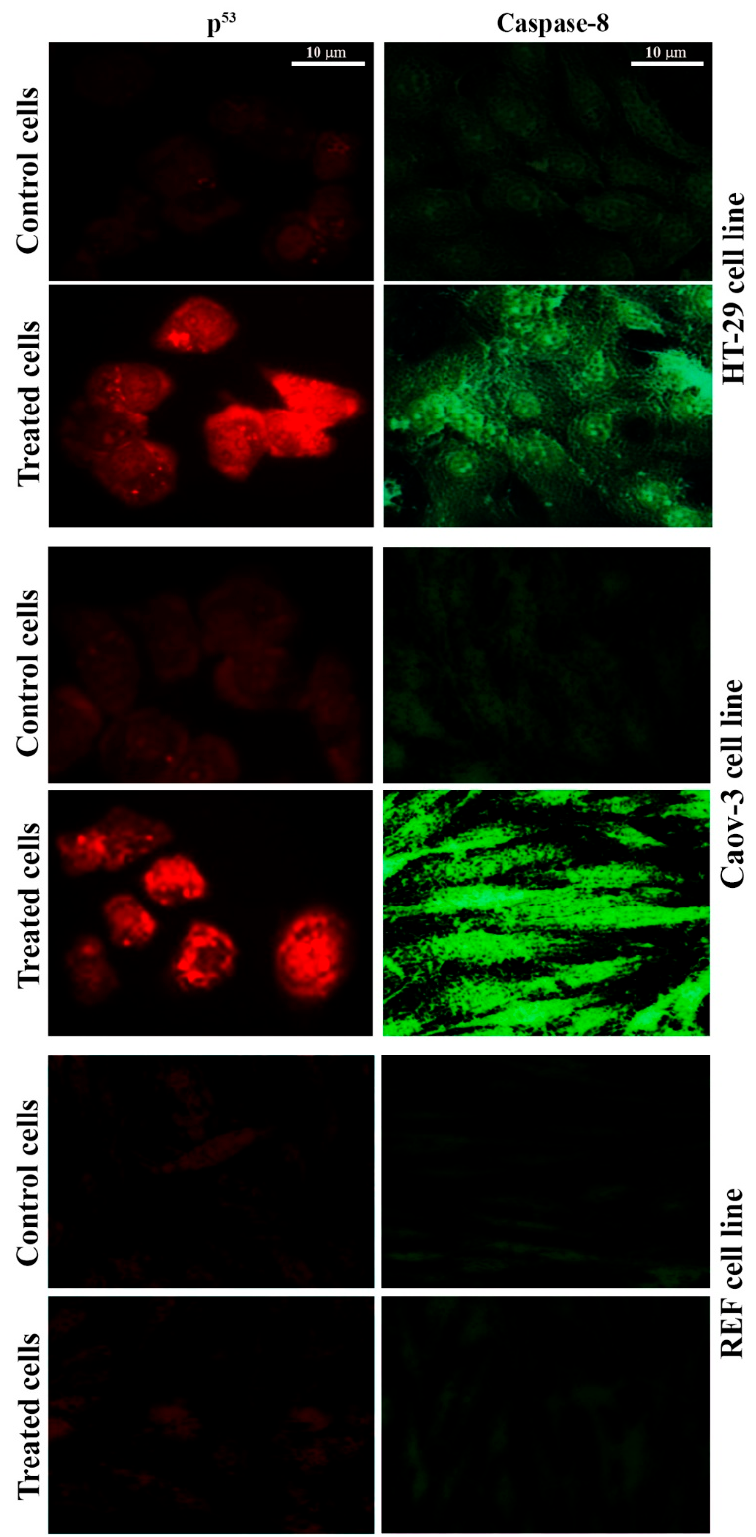
Figure 7. [Pt(H 2 L)(PPh 3 )] complex inducing apoptosis through p53 and Caspase-8 pathway. Im- munofluorescence results of p53 and Caspase-8. Cells were untreated (control), or treated with [Pt(H 2 L)(PPh 3 )] complex as indicated. Cells were fixed, permeabilized, and then stained with pri- mary and secondary antibodies. Scale bar 10 μ m.